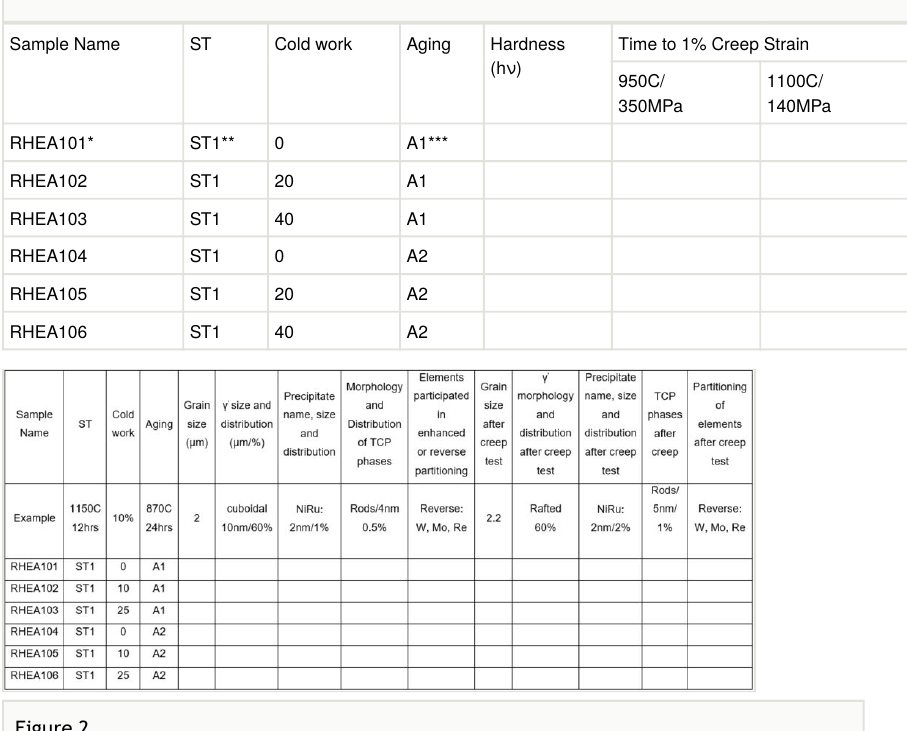
Hardness and creep rupture life of six samples from RHEA1 ingot. *RHEA10X – Sample from RHEA1 ingot with a thermomechanical history represented by X, **ST1 – Solution Treatment